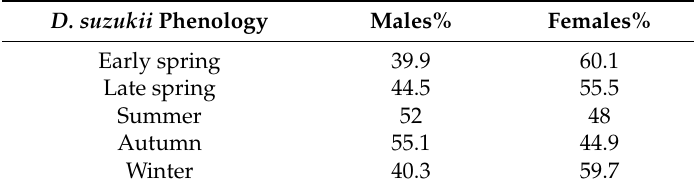
Table 5. Percentages of male and female D. suzukii captures in different seasons over the monitoring period.